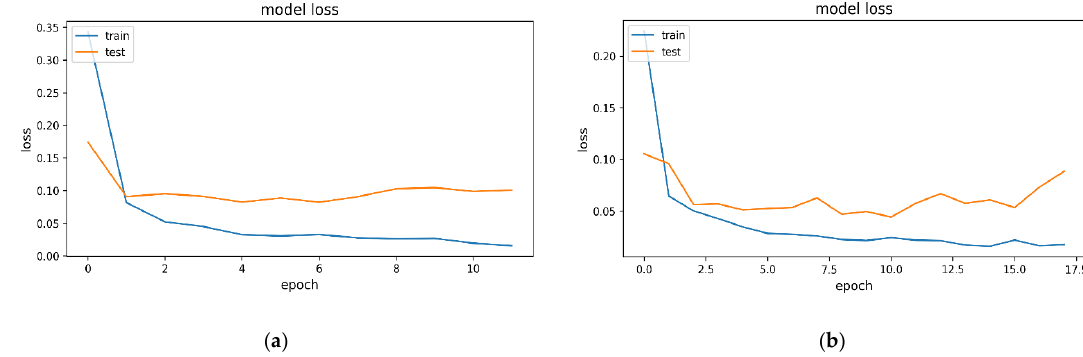
Figure 10. Training and testing loss for SACNN with VGG19 model: ( a ) with class balancing on 25 Malware classes; ( b ) with class balancing on benign class.